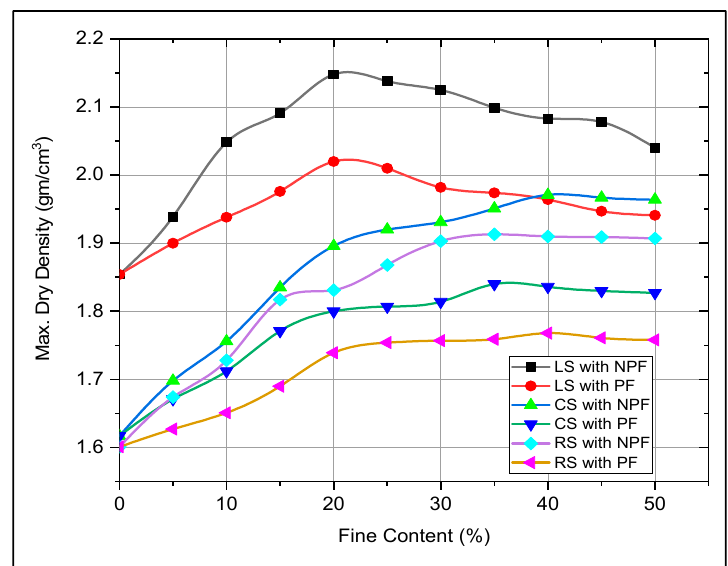
Figure 3. Variation in maximum dry density with different fine contents.